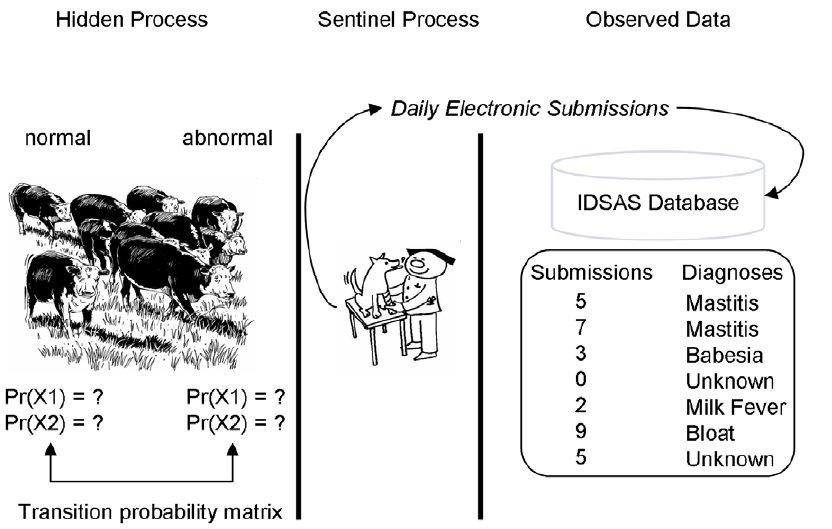
Figure 2. Data Generating Processes. Conceptual model of data generating processes in the Infectious Disease Surveillance and Analysis System in the context of hidden markov models. The hidden states of interest are the normal or abnormal state of animal health as seen by field veterinary surgeons. Observed data may include weekly submission counts, or counts of specific reported diagnoses.